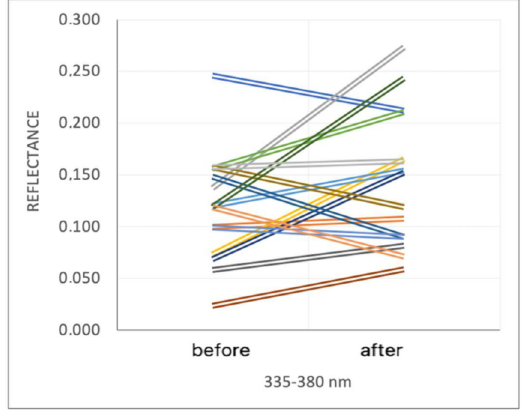
Figure 1. Average results of 3 reflectance measurements at a wavelength of 335–380 nm in every woman undergoing microdermabrasion, before and after the procedure.